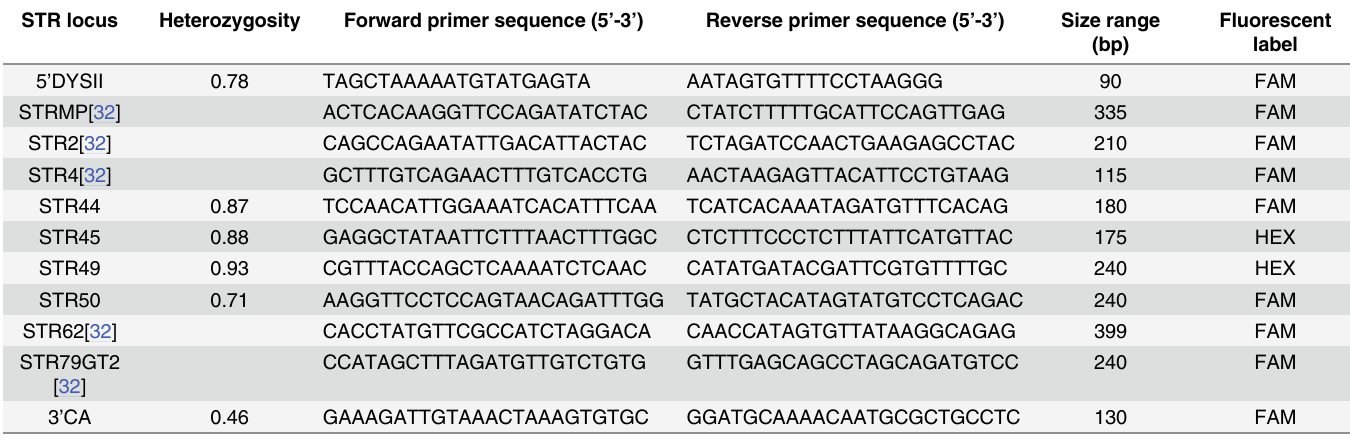
Table 4. The information of STR for DMD. STR locus Fluorescent